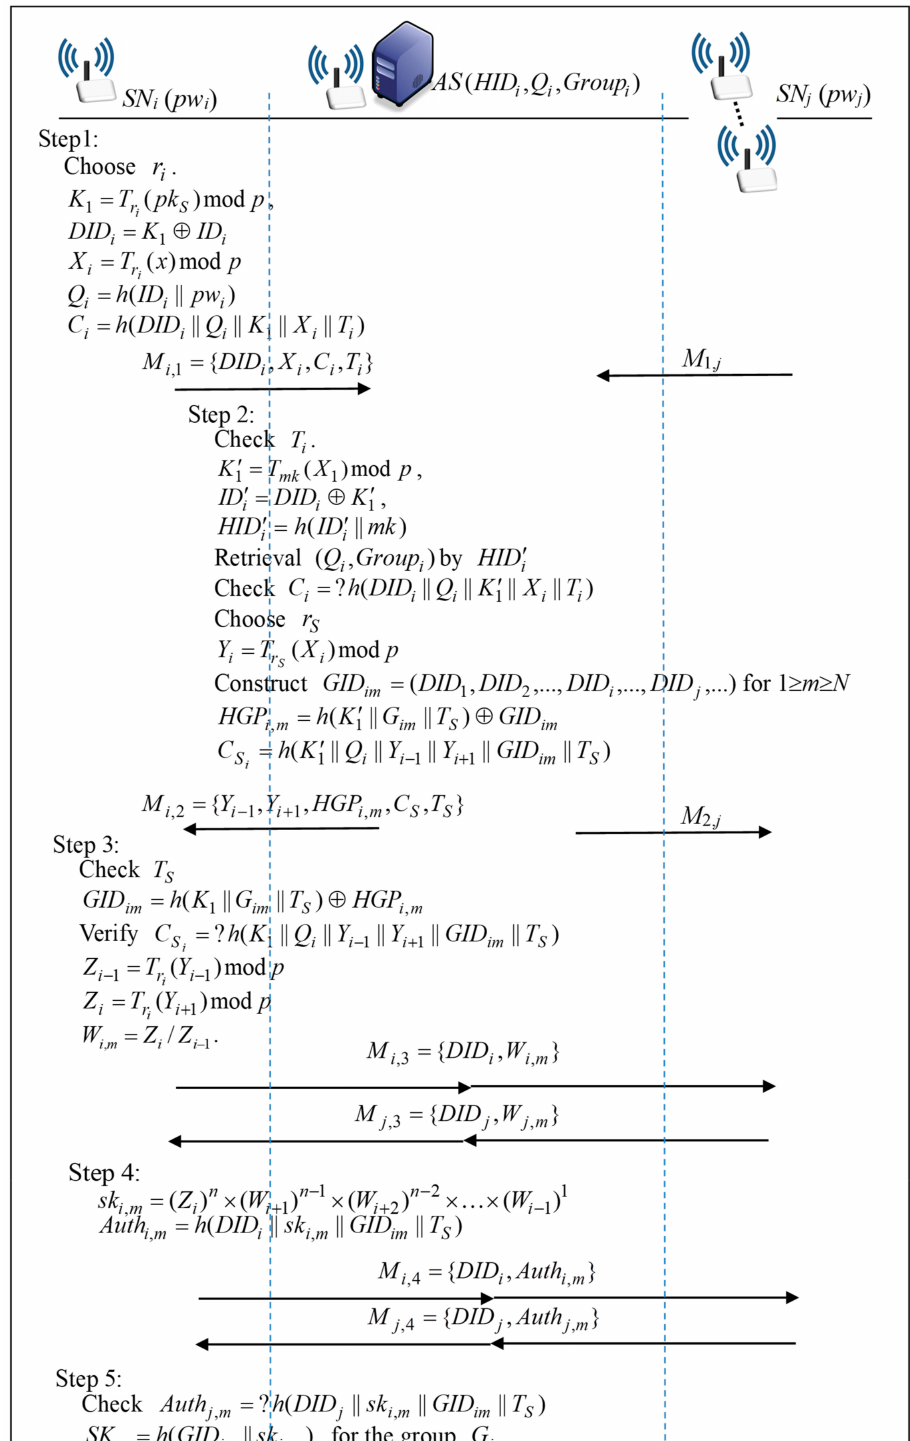
Figure 2. The proposed multi-group authenticated key agreement protocol for wireless sensor networks